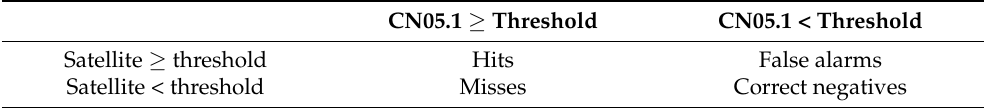
Table 2. Contingency table for comparing ground interpolation product and satellite precipitation